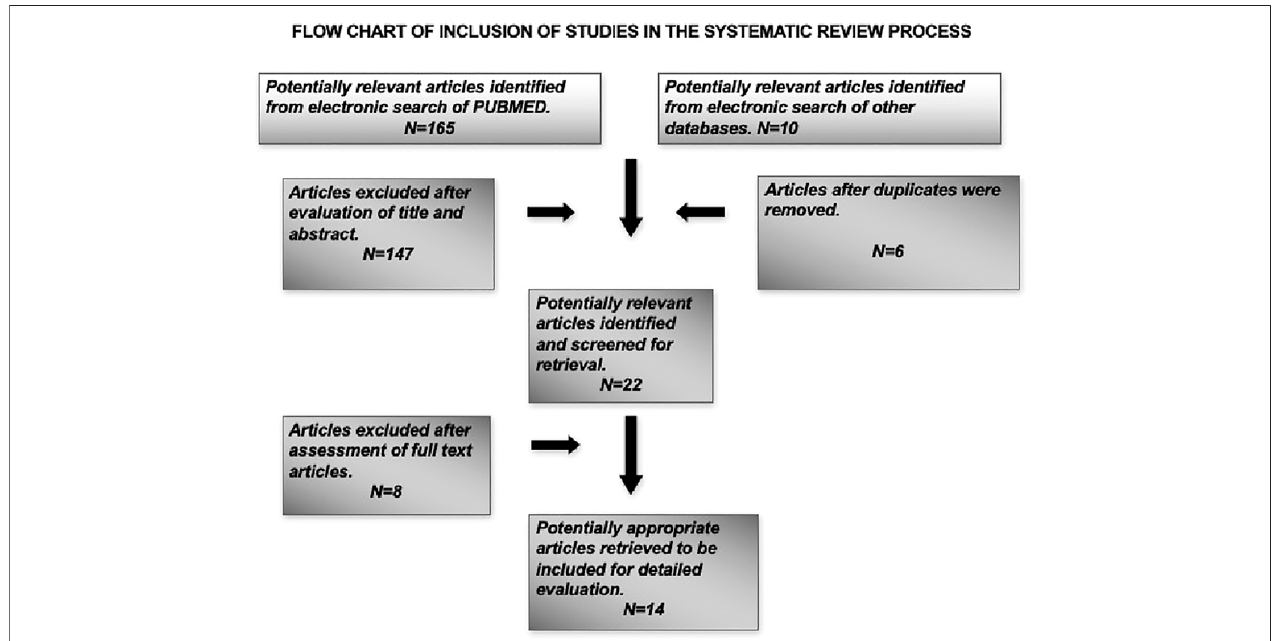
FIGURE 1 | Flowchart of search methodology and inclusion of studies in the systematic review.